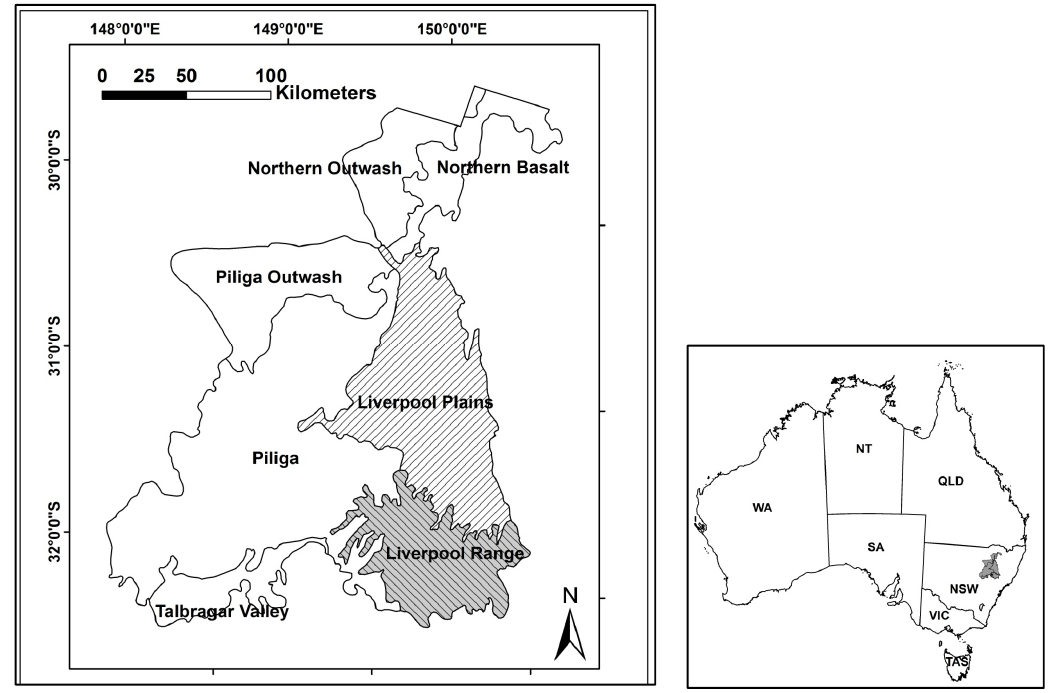
Figure 1. Location of the Liverpool Plains (LP) and Liverpool Range (LR) provinces in the Brigalow Belt South Bioregion, NSW, Australia.